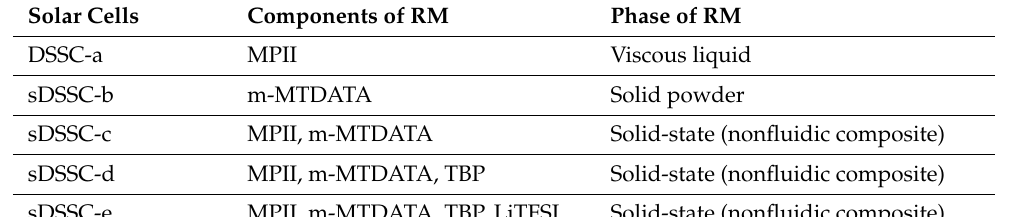
Table 2. Fabricated DSSCs with five different types of RM for comparison.